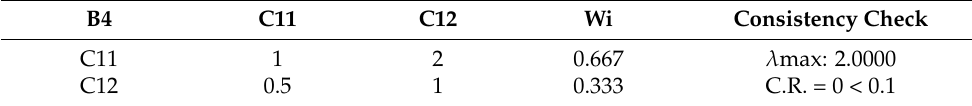
Table 13. B4–C judgment matrix and weight assignment.